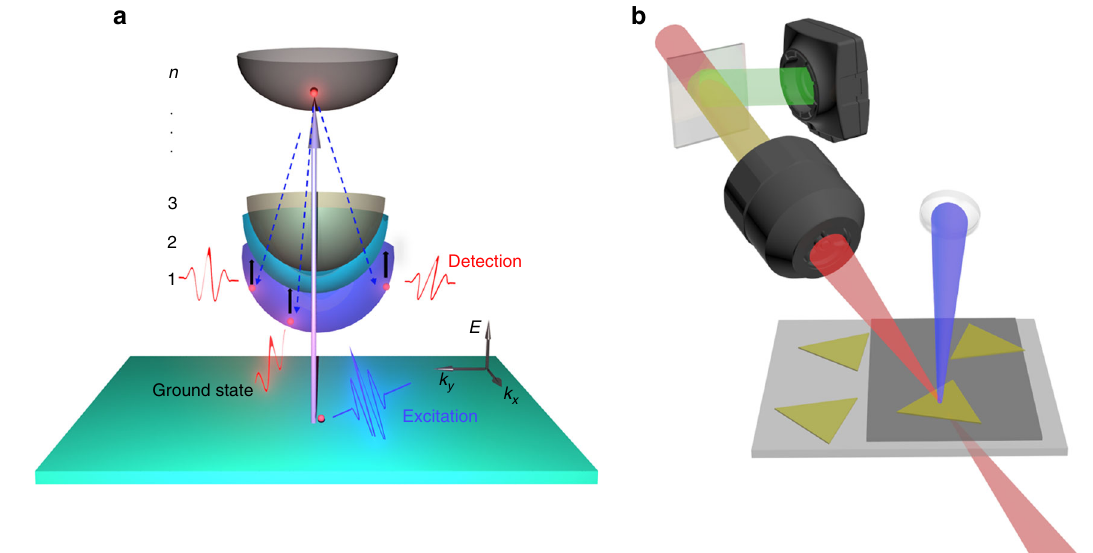
Fig. 1 Illustration of experimental setup and principle. a Mid-IR probes the excitonic internal quantum transition 1s-2p with a broad momentum distribution. Optical excitation generates free carriers with negligible momentum change. Scattering of free carriers (dash lines) into the exciton states involves large momentum transfers. b Illustration of the experimental setup. The IR probe is focused by an objective lens and transmits through the sample, detected by a MCT array detector behind the sample. The re fl ected visible light through the objective lens is collected by CCD to position the light/matter interaction spot. By tuning the sample stage, heterostructure, graphene, and MoSe 2 can be respectively studied on the same CaF 2 substrate. Triangles and the light- black layer represent single-layer MoSe 2 and graphene,